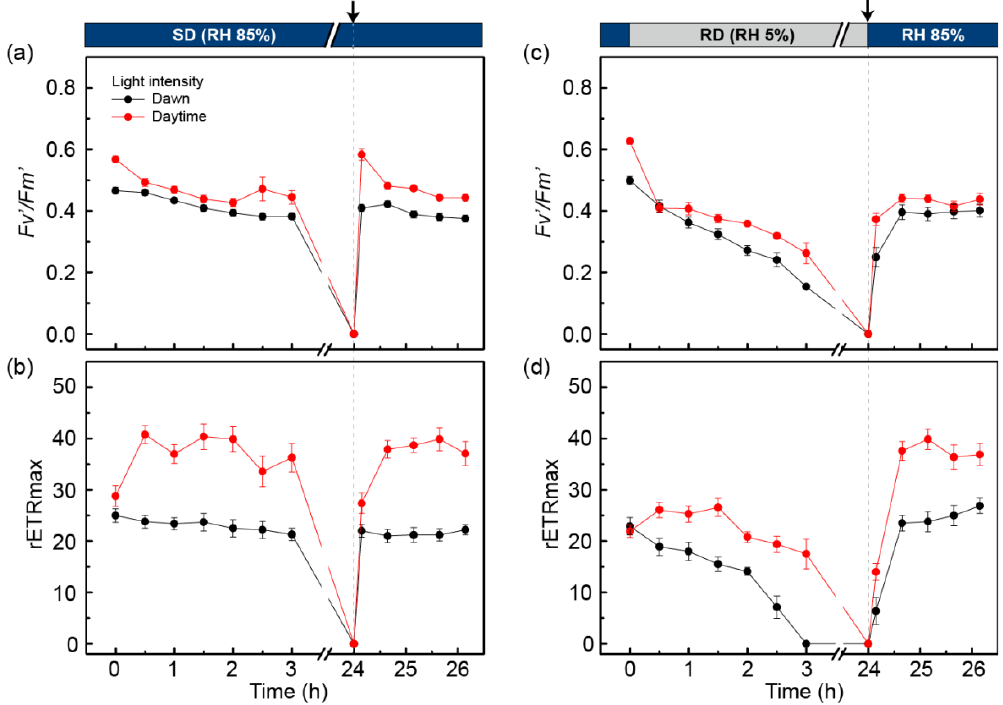
Figure 4. Changes in maximal photosynthetic yield ( Fv ’ / Fm ’) ( a , c ) and rETRmax ( b , d ) with dawn-light (50 µ mol / m 2 / s) and daytime-light (220 µ mol / m 2 / s) under a desiccation-rehydration cycle in C. borealis . Before desiccation, samples were activated with light (50 µ mol / m 2 / s) for 2 h under fully hydrated conditions with distilled water. The thalli were treated under slow desiccation (SD, 85% RH) ( a , b ) and rapid desiccation (RD, 5% RH) ( c , d ) for 24 h (until indicated by the dashed line), and then rehydrated with a water spray of distilled water (black arrow). After the removal of excess water, both samples were kept under SD conditions for an additional 2 h. The ten biological replicates were used for each treatment ( n = 10). Experiments were repeated at least two or three times using the same thalli after re-stabilizing at 50 µ mol / m 2 / s light with an 18:6 light:dark cycle at 8 ◦ C with hydration for a week. Results are the means with ± standard deviation shown by vertical bars.